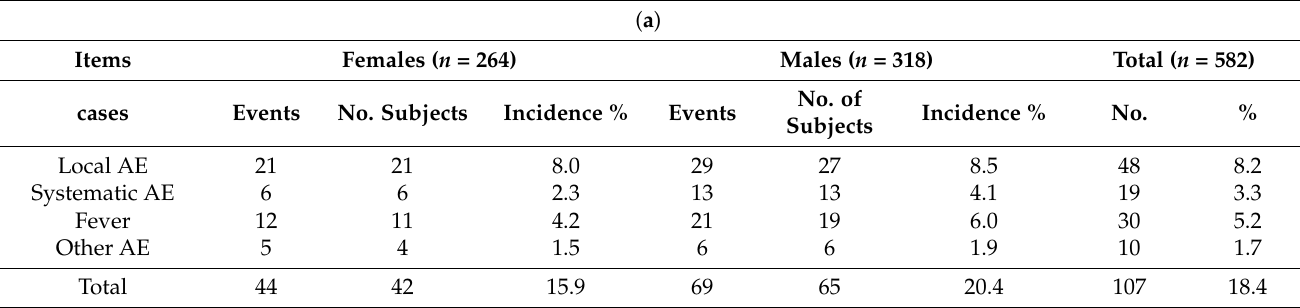
Table A2. (a ) Adverse events incidence after the first dose stratified by sex. ( b ) Adverse events incidence after the second dose stratified by